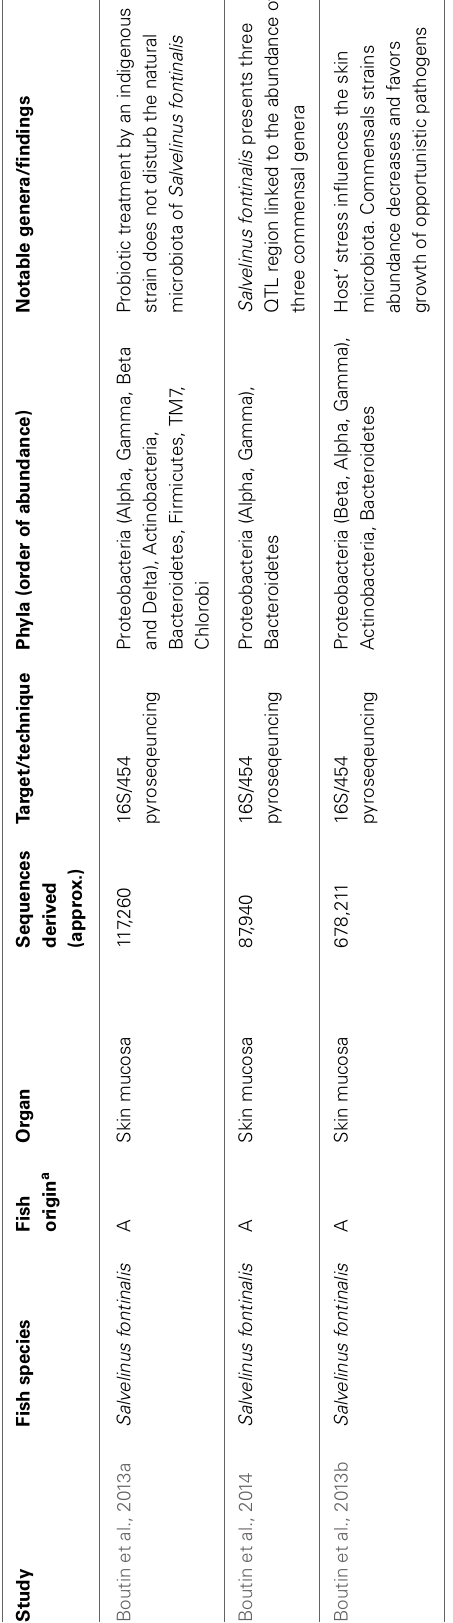
Yersinia, Renibacterium, and Mycobacterium (Austin and